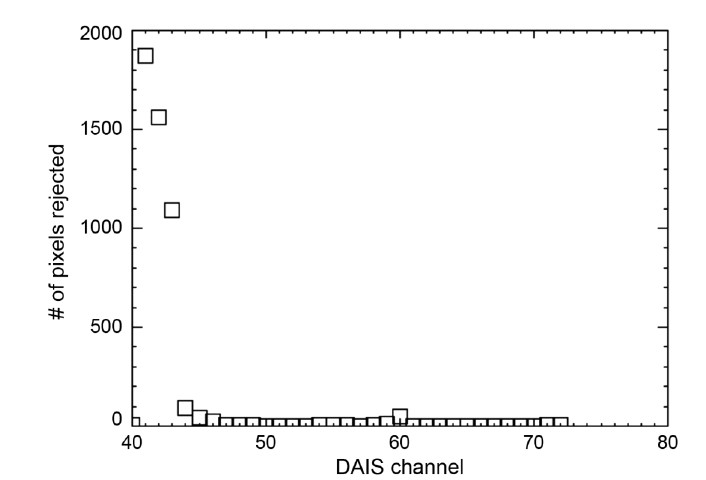
Fig. 7. Histogram of the number of pixels where the DB algorithm does give solutions, but pixels are rejected by the chosen selection criteria. The rejected pixels are concentrated in the first channels of the third spectrom- eter.